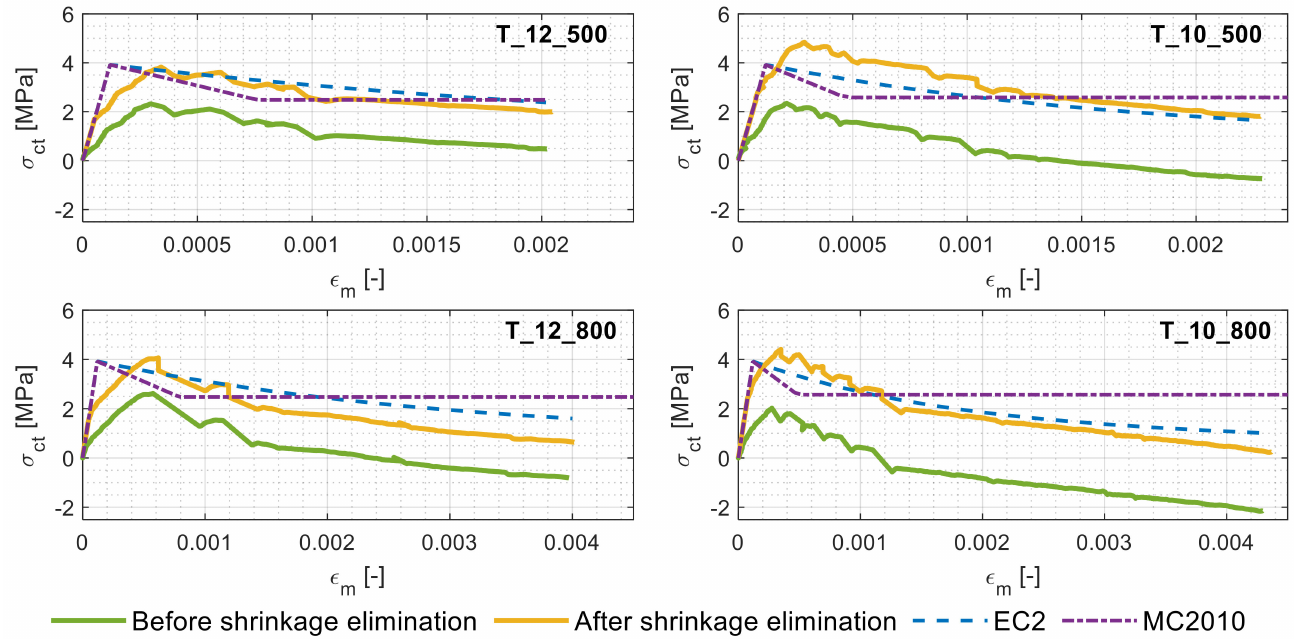
Figure 8. Tension stiffening behaviors of the study case members before and after shrinkage elimination along with the EC2 and MC2010